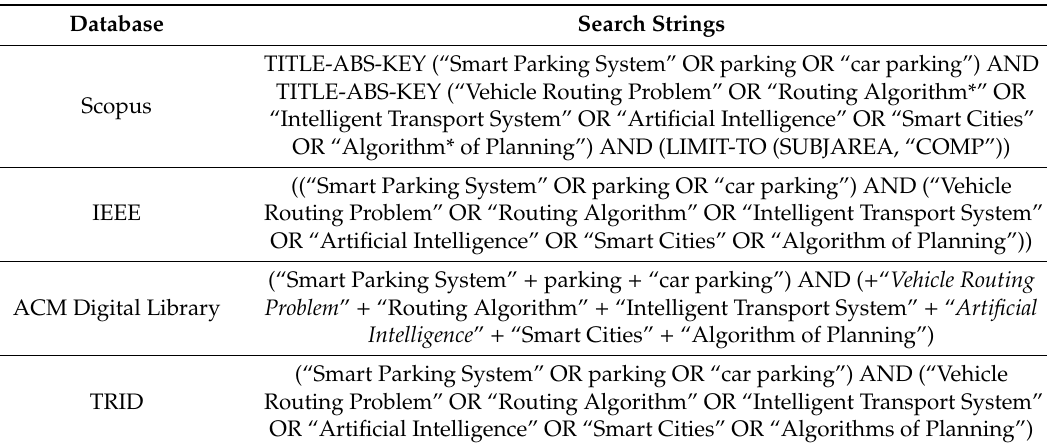
Table 3. Search strings for online